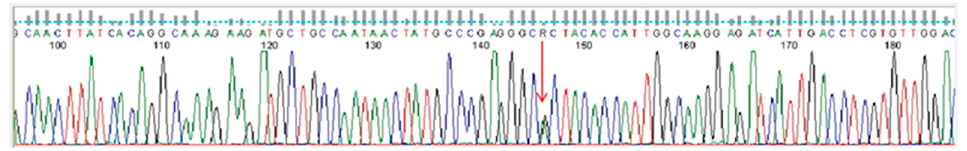
Figure 3. Partial electropherogram of the Sanger sequencing of TUBA1A in the patient shows (red arrow) the c.320A>G